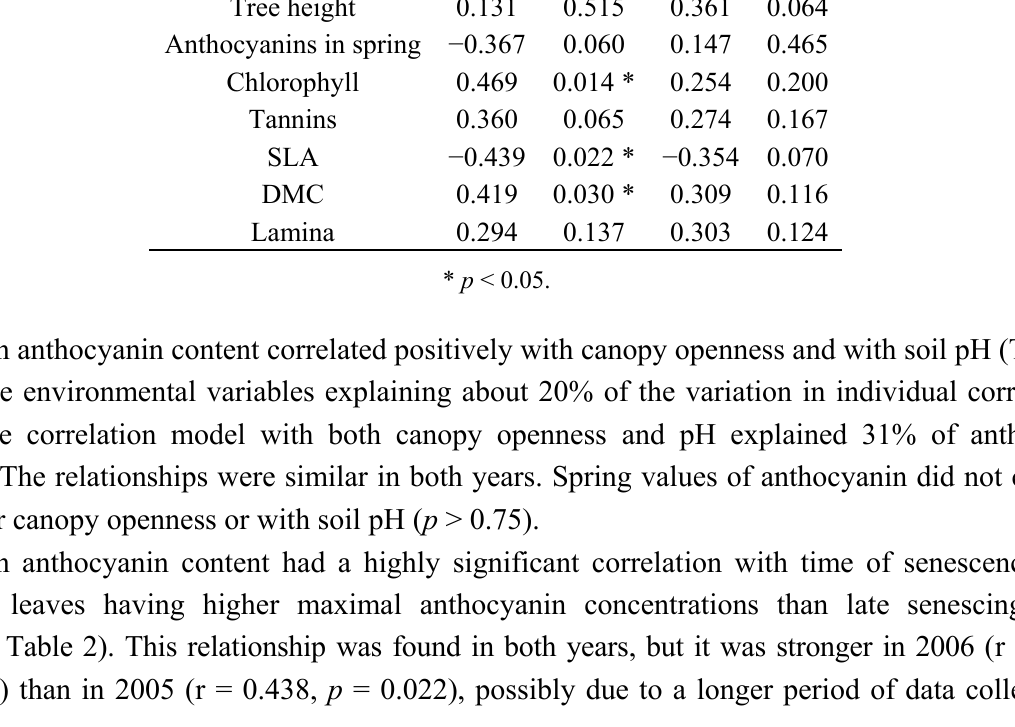
Figure 4. Leaf anthocyanin concentrations in the 27 investigated Acer rubrum trees during 2006 expressed as Anthocyanin Absorbance Index (AAI, absorbance at 532 nm minus 24% of absorbance at 653 nm [24]). Table 2. Correlations of leaf autumn anthocyanin content and earliness of senescence (chlorophyll degradation by mid-late September) with tree height, leaf anthocyanin content in spring, and the summer leaf traits leaf chlorophyll contents, tannin contents, Specific Leaf Area (SLA), dry matter content (DMC), and lamina thickness ( n = 27). Anthocyanins Senescence r p r p Tree